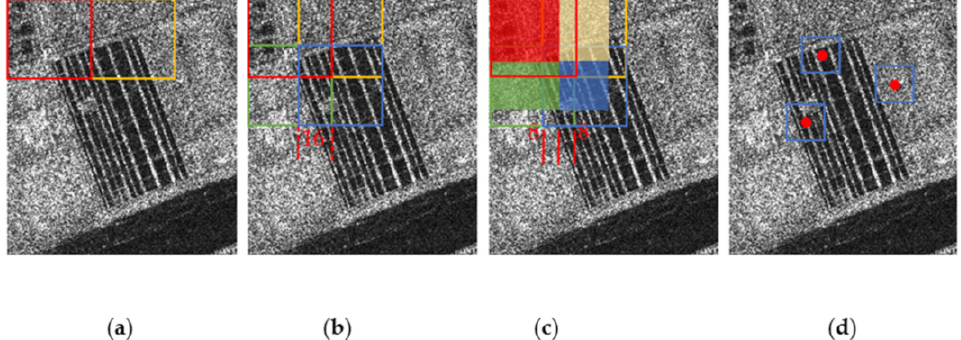
Figure 5. Method of cropping patches from images: ( a ) crop without overlap and ( b ) crop with overlap of 16 pixels. ( c ) Blocks in different colors will be chosen as final results and stitched together into a final change map. ( d ) Other patch-based SAR image change the detection task (classifying only the center pixel for a patch).